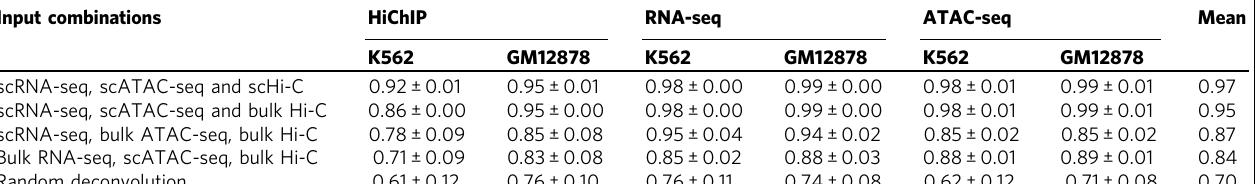
Table 1 The deconvolution performance of DC3 with different input combinations Input combinations HiChIP RNA-seq ATAC-seq scRNA-seq, scATAC-seq and scHi-C